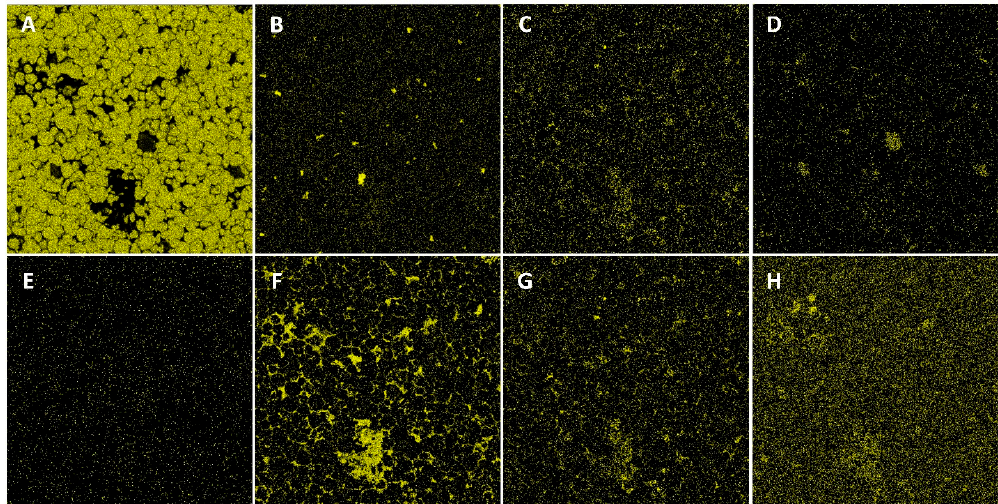
Figure 2. SEM-EDS elemental distribution maps for aluminum ( A ), silicon ( B ), molybdenum ( C ), copper ( D ), zinc ( E ), tin ( F ), lead ( G ) and magnesium ( H ) for M1 alloy.